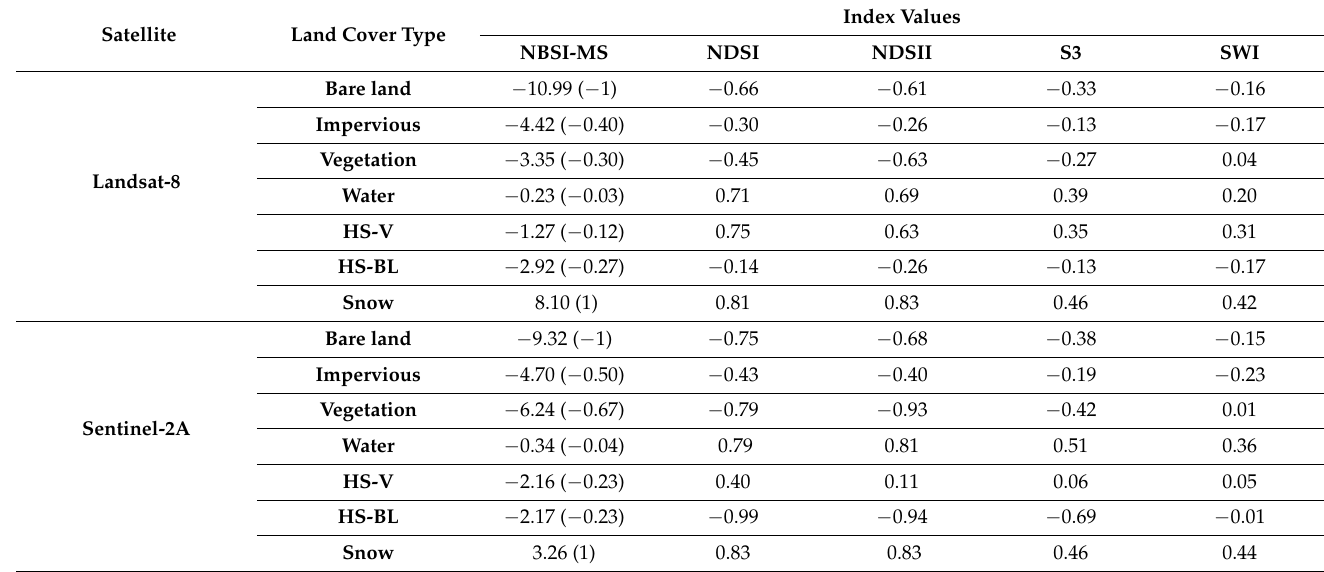
Figure 6. Plots of the resulting index values (mean ± standard deviation) obtained by computing the mathematical expressions in Table 3 and Equation (1) by taking the values in Table 4 for the different Snow-Cover Indices (SCIs). The list of SCIs is given as the snow/ice index values increase. The NBSI-MS actual values were normalized to analyze the different SCIs under the same scale, while HS-BL is the Hilly Shadow over Bare Land, and HS-V is the Hilly Shadow over Vegetation. Table 5. Values of the indexes plotted in Figure 6a,b for the different Snow-Cover Indices. “The NBSI-MS values were normalized as shown in parenthesis in the range [ − 1, 1]” to compare the proposed method in the same range as NDSI, NDSII, S3, and SWI. Note: The snow index value is a single number that quantifies the snow cover computed by Equation (1) and the expressions in Table 3 taking the values in Table